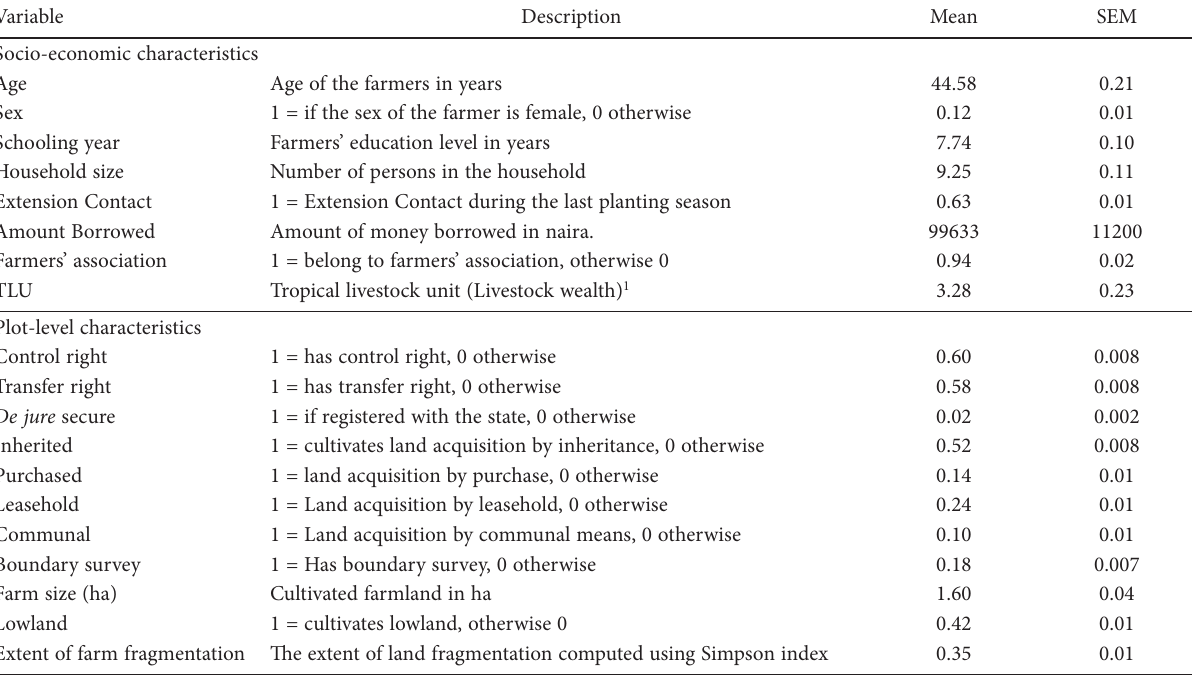
Table 3. Definitions and Summary Statistics of the Variables Used in the